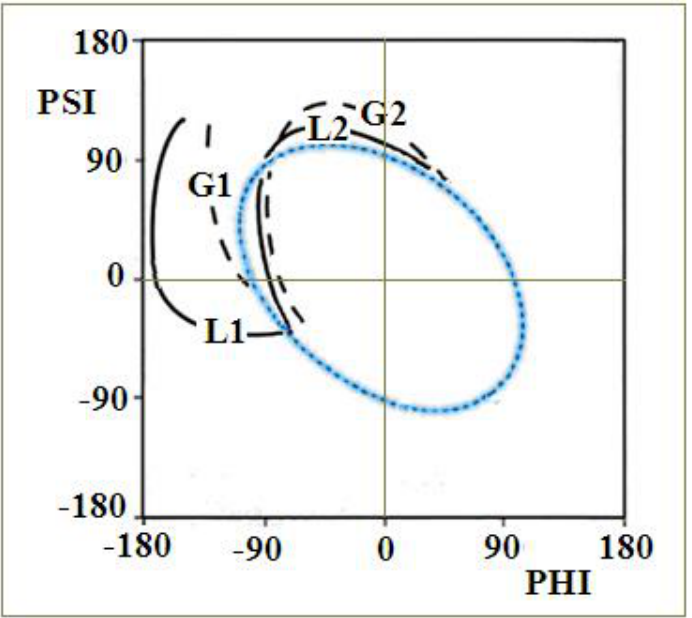
Figure 2. Two paths determined on the basis of the distribution of Phi and Psi angles obtained by molecular dynamics [38,39]. Line L1—unfolding of the α -helix with increasing radius of curvature of the chain obtained for unfolding of the free α -helix, Line L2 and G2—structural changes leading to unfolding of the α -helix as a component of the BPTI structure by reducing the radius of curvature. Line G1—an alternative route for the unfolding of the α -helix as a component of a longer polypeptide chain in a protein. The blue line (ellipse) is the optimal path for structural changes as identified using the early-stage model described in Materials and